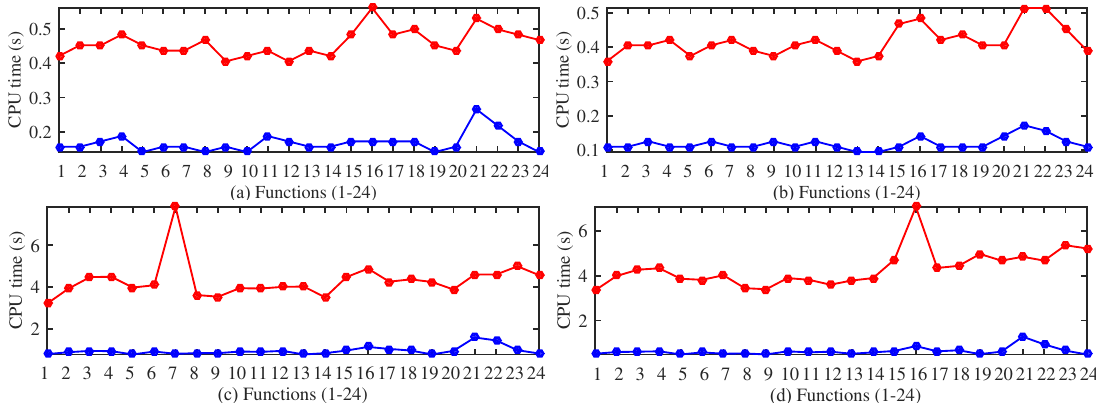
Figure 4. Comparative study of the CPU time of GDS (blue) and DIRECT (red) for solving 24 problems of dimension five ( a ) and dimension 10 ( b ) using 10 3 function evaluations ( c ) and 10 4 function evaluations ( d ).